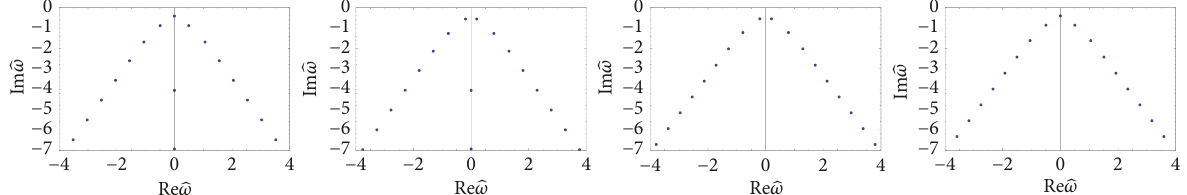
Figure 24: QNMs (blue spots) of the gauge mode for |𝛾 2 | = 1/24 (the first two panels are for 𝛾 2 = −1/24 and the second two panels for 𝛾 = 1/24 ) and ̂𝛼 = 1/2 . The first and third panels are the QNMs of the gauge mode and the second and forth panels are that of the dual gauge 2 mode.